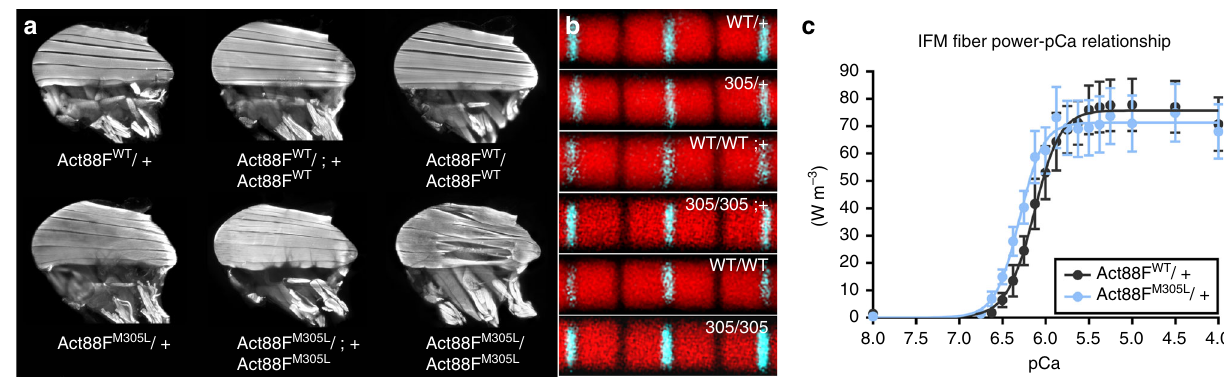
Fig. 3 M305L actin causes IFM hypercontraction and enhances Ca 2 + sensitivity. a Fluorescent micrographs of dorsal longitudinal IFMs (DLMs) of two-